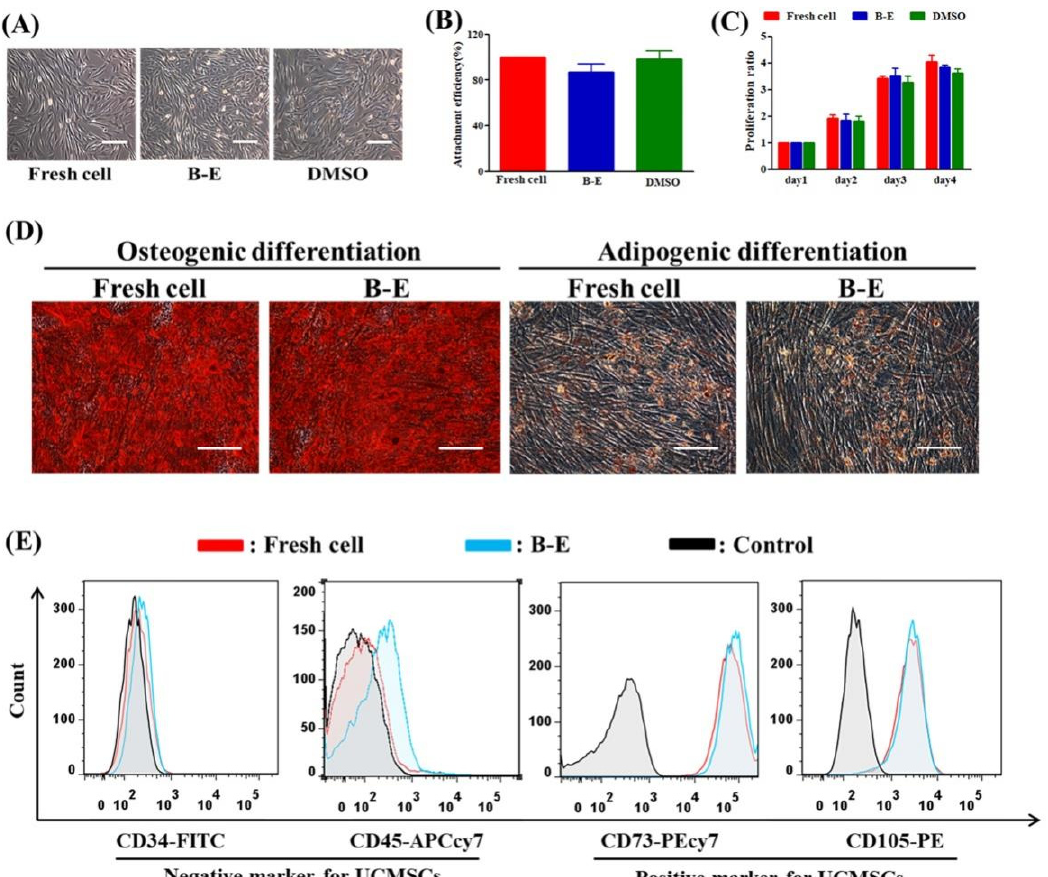
Figure 4. Evaluation of UCMSCs functions. ( A ) Morphology. ( B ) Attachment efficiency. ( C ) Proliferation ability. ( D ) Qualitative assessment of osteogenic and adipogenic differentiation (stained by Alizarin Red and Oil Red O, respectively). ( E ) Flow cytometry quantification of the expression of CD34 and CD45 (negative markers), CD73, and CD105 (positive markers). Control group refers to UCMSCs without cryopreservation and staining process. Scale bar = 200 µ m. Value = mean ± standard deviation, n = 3.